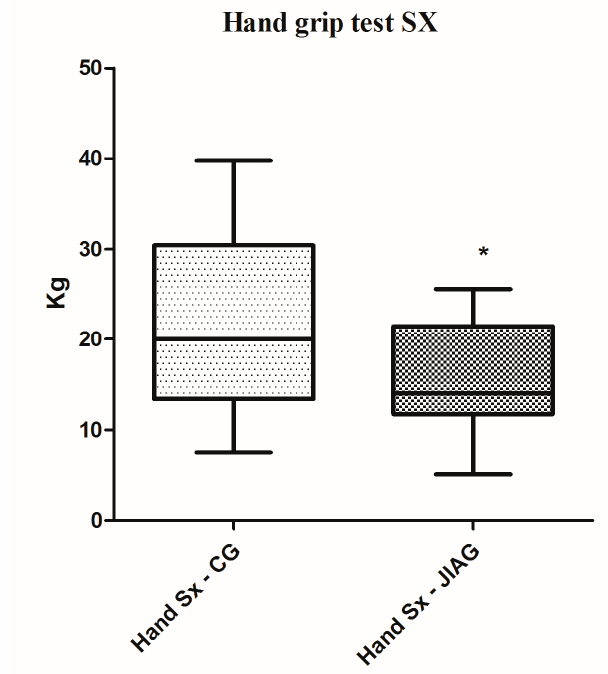
Figure 5. Analysis of hand grip (SX) performances among the group of the healthy subjects (CG) and subjects with juvenile idiopathic arthritis (JIAG). * indicated that p < 0.05.